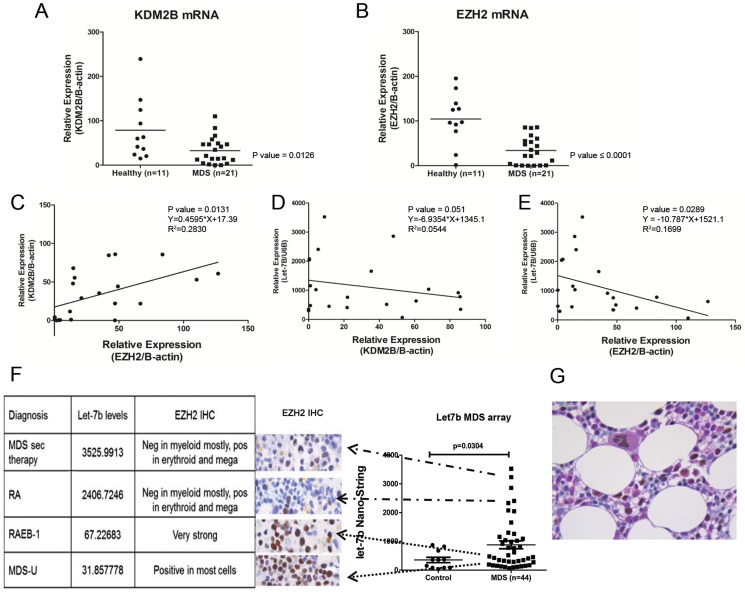
KDM2B, and EZH2 expression in myeloid cell lines and primary MDS marrow cells.Expression of KDM2B, A) and EZH2, B) in marrow cells from MDS patients (n = 21) and healthy controls (n = 11) (p = 0.0126 and <0.001, respectively, Student t-test). C) Direct correlation of KDM2B and EZH2 (p = 0.0131, R2 = 0.2830, 95%CI 0.1300–0.7837), D) Inverse correlation of let-7b and KDM2B, E) Inverse correlation of let-7b and EZH2. F) Immunohistochemistry (IHC) for EZH2 on marrow sections from 6 patients with MDS and linkage to Let-7b levels as determined by miRNA microarray. BM CD34+ from MDS patients expressing higher levels of let-7b expressed lower levels of EZH2, and vice versa. G) EZH2 immunohistochemistry on a normal marrow with Periodic Acid-Schiff stain as the counter stain was used for the purpose of lineage differentiation. The large cells with brown nuclear staining are a morphologically normal megakaryocytes, positive for EZH2. Of the remaining cells, eosinophilic cells of myeloid lineage and show low level variable reactivity for EZH2, while the remaining erythroid cells show dim to moderate reactivity for EZH2, underscoring the relevance of lineage specific EZH2 expression.